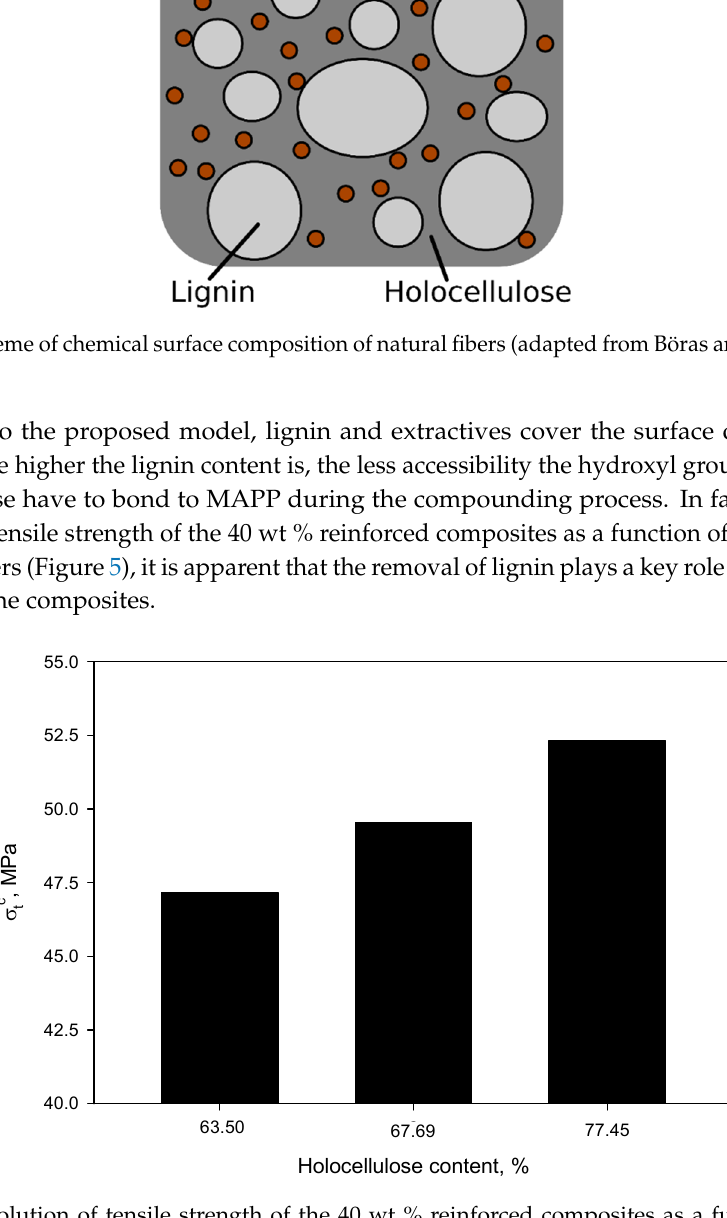
Figure 5. Evolution of tensile strength of the 40 wt % reinforced composites as a function of the holocellulose content in the reinforcement.